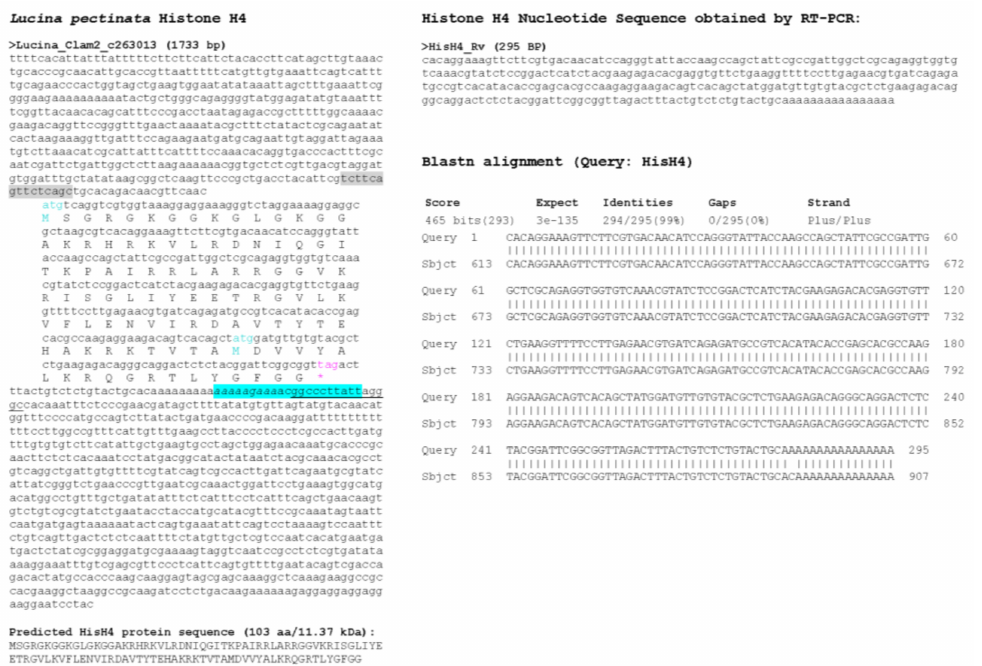
Figure 8. Histone H4 sequence found in L. pectinata genome assembly. ( A ) The H4 nucleotide sequence obtained from the BLASTN searches against the L. pectinata genome assembly using the H4 nucleotide sequences from S. marginatus is shown, with the ORF translation, the predicted protein sequence and its molecular weight (MW). Primers used in RT-PCR are highlighted in cyan and grey. Start (cyan) and stop (pink) codons are indicated. ( B ) The sequence obtained by Sanger sequencing of RT-PCR products by the BLASTN alignment to the genomic sequence, showing a perfect match between the two